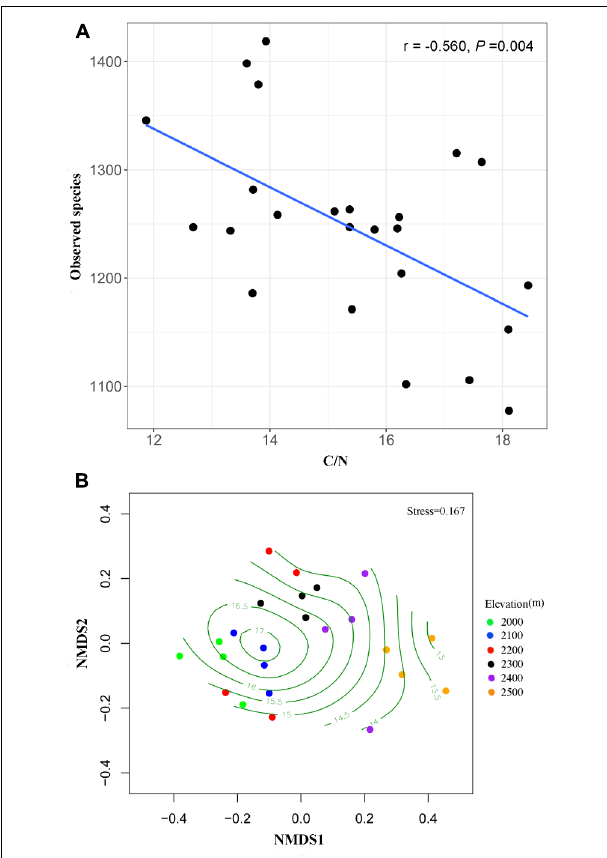
FIGURE 3 | Effects of C/N ratio on the alpha and beta diversity of soil fungi. Alpha diversity index (observed species) decreased with increasing C/N ratio (A) . NMDS plot showing the best separation of samples along the C/N ratio gradients (B) .